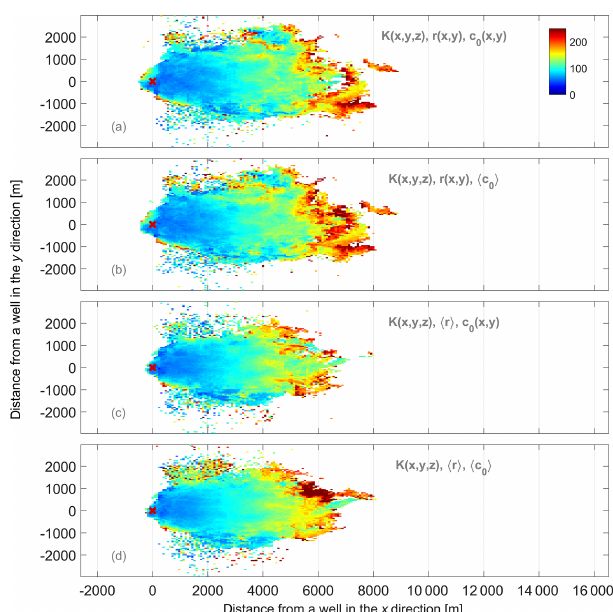
Figure 5. Expected travel time (years) of a particle leaving a given grid cell and reaching a well for a heterogeneous r and heteroge- neous c 0 (reference case, a ); a heterogeneous r and homogeneous c 0 (b) ; a homogeneous r and heterogeneous c 0 (c) ; a homogeneous r and homogeneous c 0 (d) ; a ln K -weighted r and ln K -weighted c 0 (e)